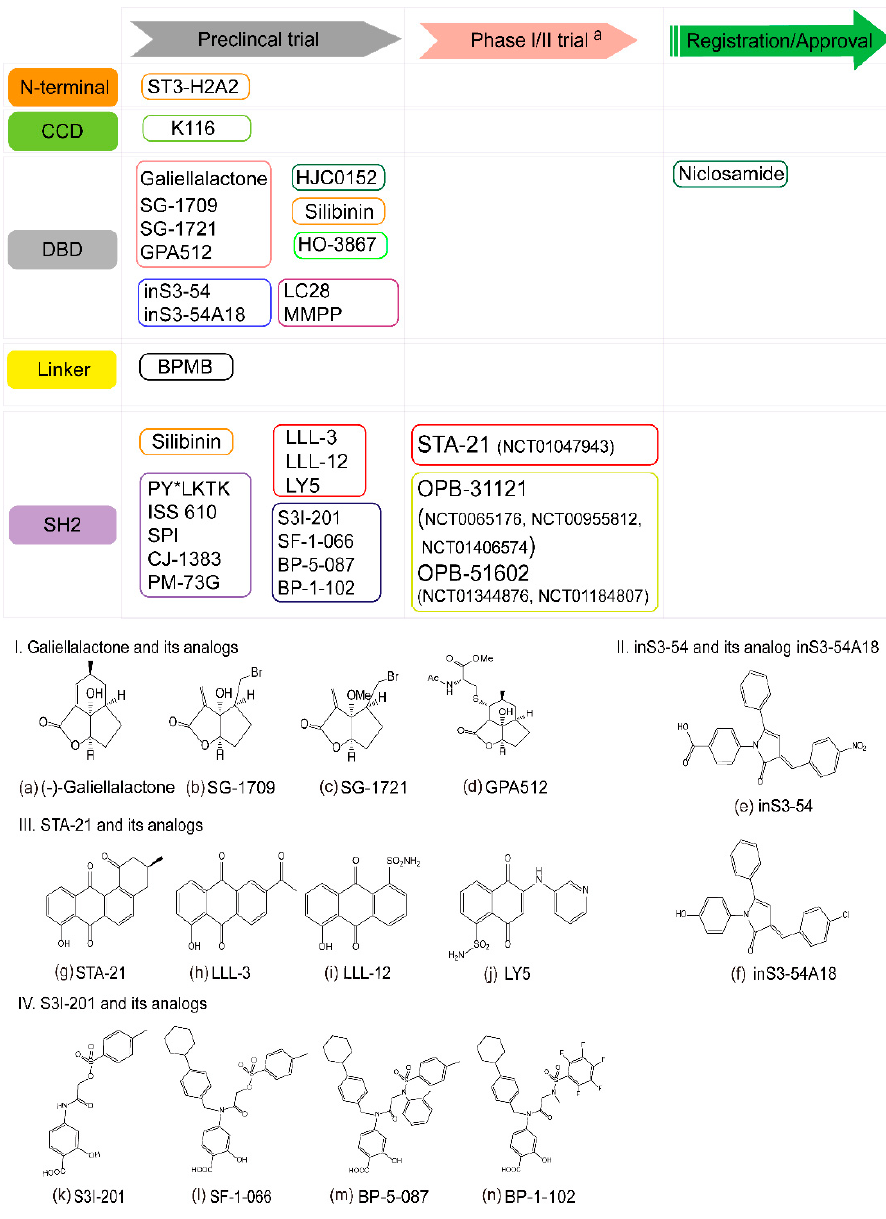
Figure 3 . The current status of STAT3 inhibitors in (pre)clinical trials and their chemical structures. The N-terminal domain, DNA-binding domain (DBD), coiled-coil domain (CCD), linker domain and Src homology 2 domain (SH2) are components of the STAT3 structure. a Inhibitors of Phase I/II clinical trials registered at https://clinicaltrials.gov. (a-d), the structure of galiellalactone and its analogs. (e-f), the structure of inS3-45 and inS3-54A18. (g-j), the structure of STA-21 and its analogs. (k-n), the structure of S3I-201 and its analogs.